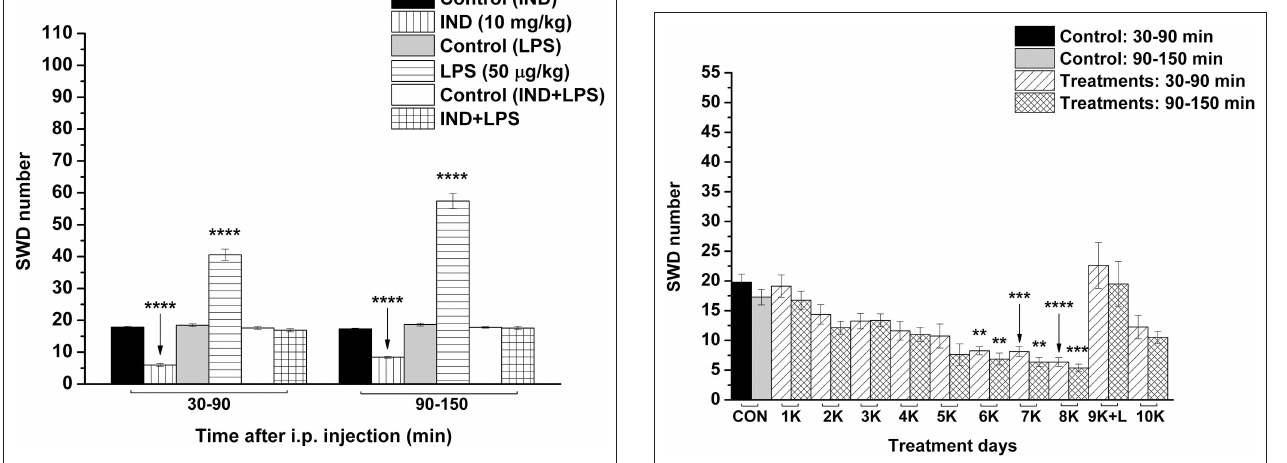
FIGURE 3 | Effect of IP indomethacin (IND: 10 mg/kg), IP lipopolysaccharide (LPS: 50 µ g/kg), and combined administration of IP indomethacin (10 mg/kg) and IP LPS (50 µ g/kg; IND + LPS) on SWD number (groups 2, 3, and 4, respectively). IND, indomethacin; i.p., intraperitoneal; LPS, lipopolysaccharide; SWD, spike-wave discharge. **** p < 0.0001 level of significance.